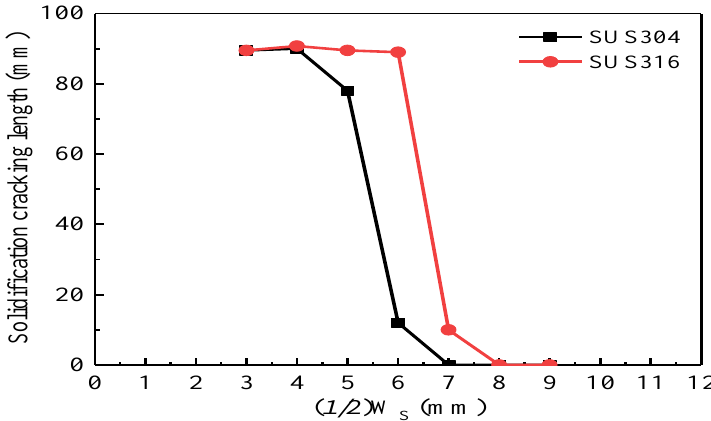
Figure 8. Effect of ( 1/2 )W S on the solidification cracking length of the SUS316 and SUS304 stainless steels during laser welding at a welding speed of 1.0 m/min.